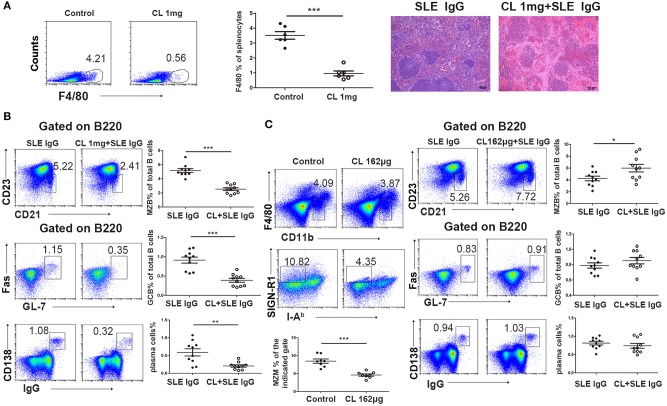
Effect of macrophages on lupus IgG-induced red pulp inflammation and GC responses. (A) FACS analysis showing that F4/80 expression in the spleen of C57BL/6 mice depleted of red pulp macrophages with 1 mg of CLs is significantly decreased compared with that in control mice treated with PBS liposomes. Representative histopathological picture of the spleen of C57BL/6 mice 3 days after intrasplenic injection of lupus IgG (200 μg), and lupus IgG (200 μg) pretreated with 1 mg of CLs. (B) FACS analysis of MZB (B220+CD21/35hiCD23lo), GCB (B220+Fas+GL7+), and IgG-secreting plasma cells (IgG+CD138+) 8 days after intrasplenic injection of lupus IgG (200 μg), and lupus IgG (200 μg) pretreated with 1 mg of CLs. (C) FACS analysis of the percentage of MZMs (F4/80negCD11bloSIGN-R1+I-Ab−) in the spleen of C57BL/6 mice injected with 162 μg of CLs and PBS liposomes as the control. Frequency of MZB (B220+CD21/35hiCD23lo), GCB (B220+Fas+GL7+), and IgG-secreting plasma cells (IgG+CD138+) 8 days after intrasplenic injection of lupus IgG (200 μg), and lupus IgG (200 μg) pretreated with 162 μg of CLs. All results are representative of three independent experiments, n > 10. *P < 0.05, **P < 0.01, ***P < 0.001.